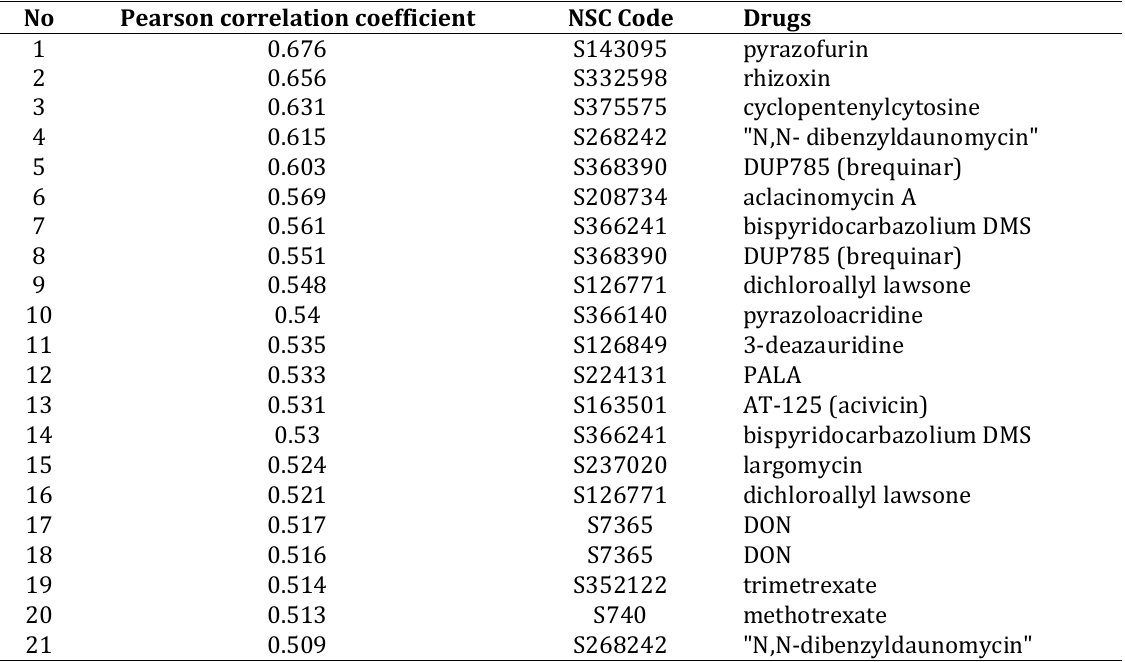
Table I. Correlation of ellipticine with standard chemotherapeutic agents, as analyzed by COMPARE.